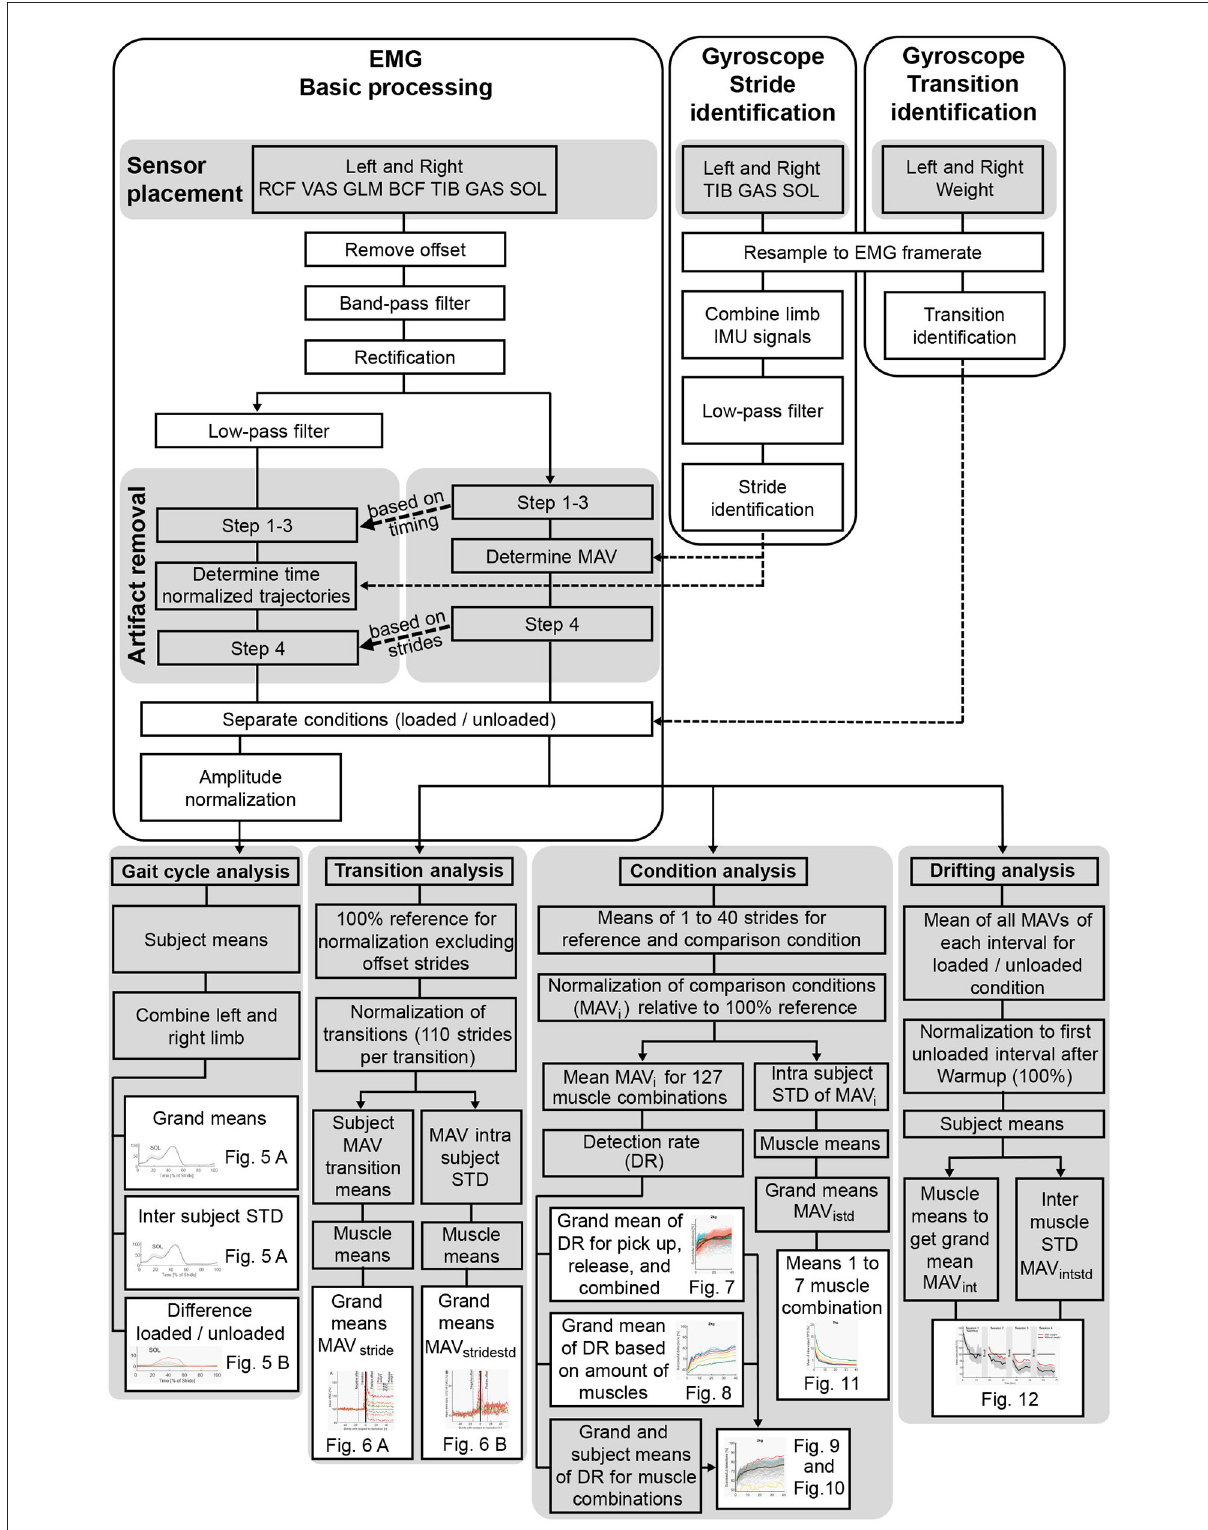
FIGURE2 Overview of the data processing from the extracted signals to the use of the computed variables in the